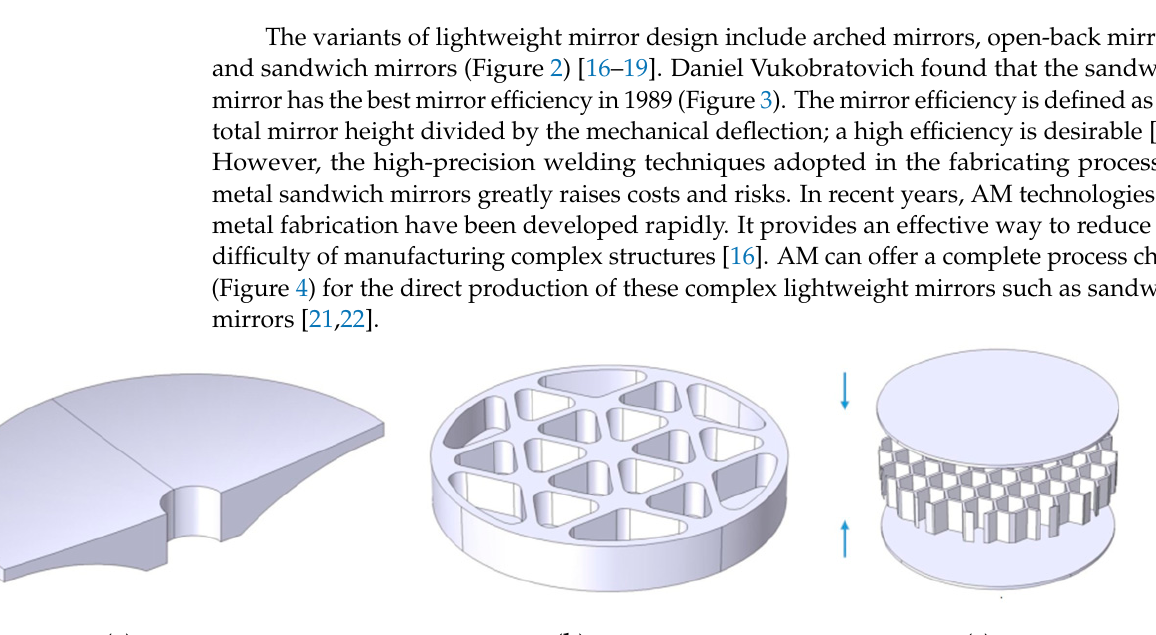
( d ) Figure 3. ( a – d ) A series of performance comparison images of 5 lightweight structures. It can be seen that the sandwich mirror has the best mirror efficiency of the [19].